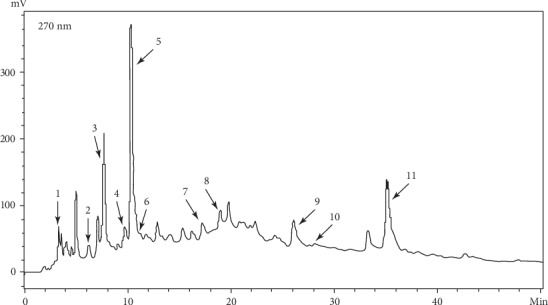
High-performance liquid chromatography of EPE. Note: 1 Gemin D; 2, 4 Pedunculagin; 3 Gallic acid; 5 Oenothein B; 6,7 TellimagrandinI; 8 Chlorongenic acid; 9 Ethyl gallate; 10 1,2,3,4,6-O-pentagalloylglucose; 11 Hyperoside.